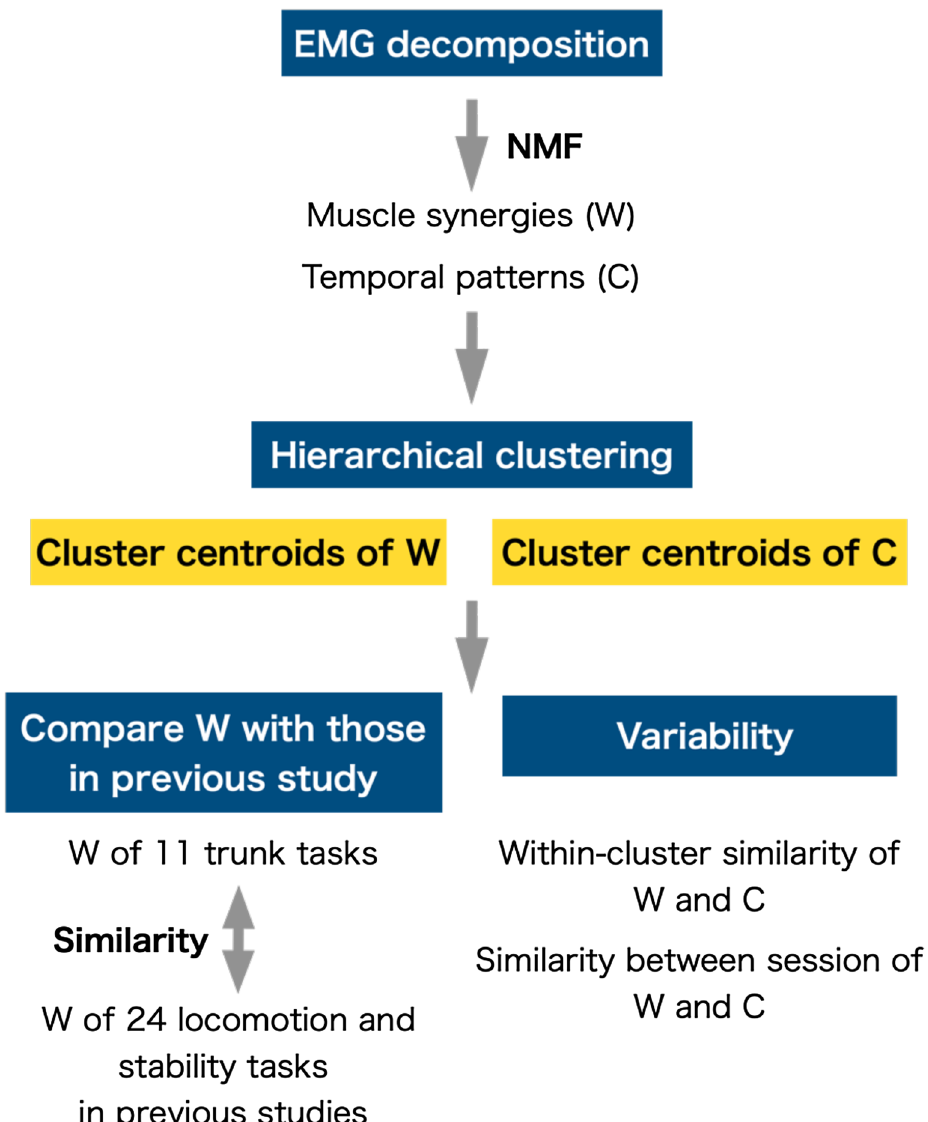
Figure 2. Flow-chart of the analysis trunk muscle synergies (W) and their temporal patterns (C). W and C were extracted using the NMF algorithm. To determine if the extracted synergies in the current study represented the same underlying a variety of locomotion and stability tasks found in our previous study 10 , the similarities found using the scalar product of the cluster centroids of W in the current study, and those extracted in the previous study (excluding muscle weighting components in the lower limbs) were computed. The analysis of variability was focused on within-cluster similarities and similarities between session in both W and C. The similarity values for W and C were computed using scalar product and the r max coefficient using the cross-correlation function,